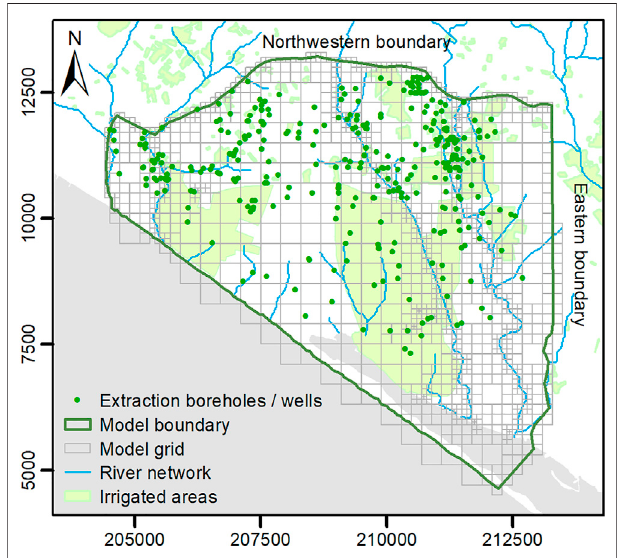
FIGURE 4 | Irrigated areas and extraction boreholes /wells, with model domain, grid and